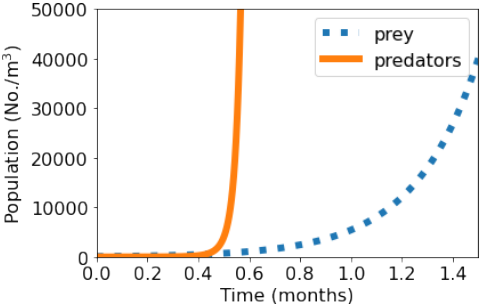
Figure 2. Short-term population dynamics of the predator–prey for α = 0. Predator and prey have the same response strength to MP particles, r 11 = r 21 = 0.1, i.e., ∆ = r 11 / r 21 = 1.0. Abscissa measures time in months and ordinate measures the number of organisms (No./m 3 ). The populations of prey ( x 1 ) and predator ( x 2 ) are represented by the blue dotted line and the orange continuous one,